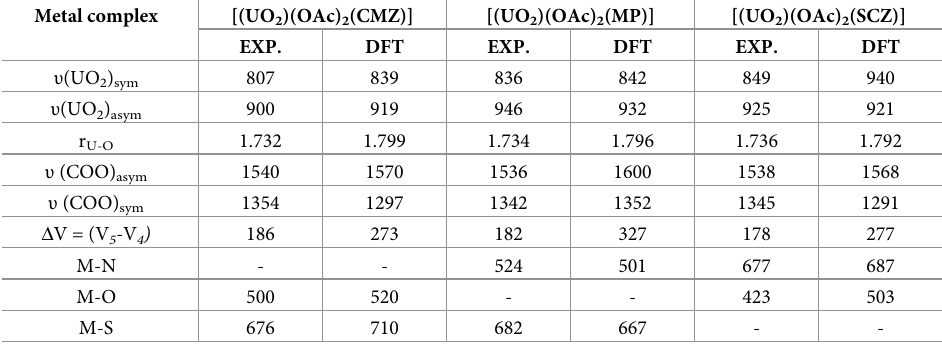
Table 2. Vibrational frequencies for the indicated band in the metal complex and the calculated ones. Metal